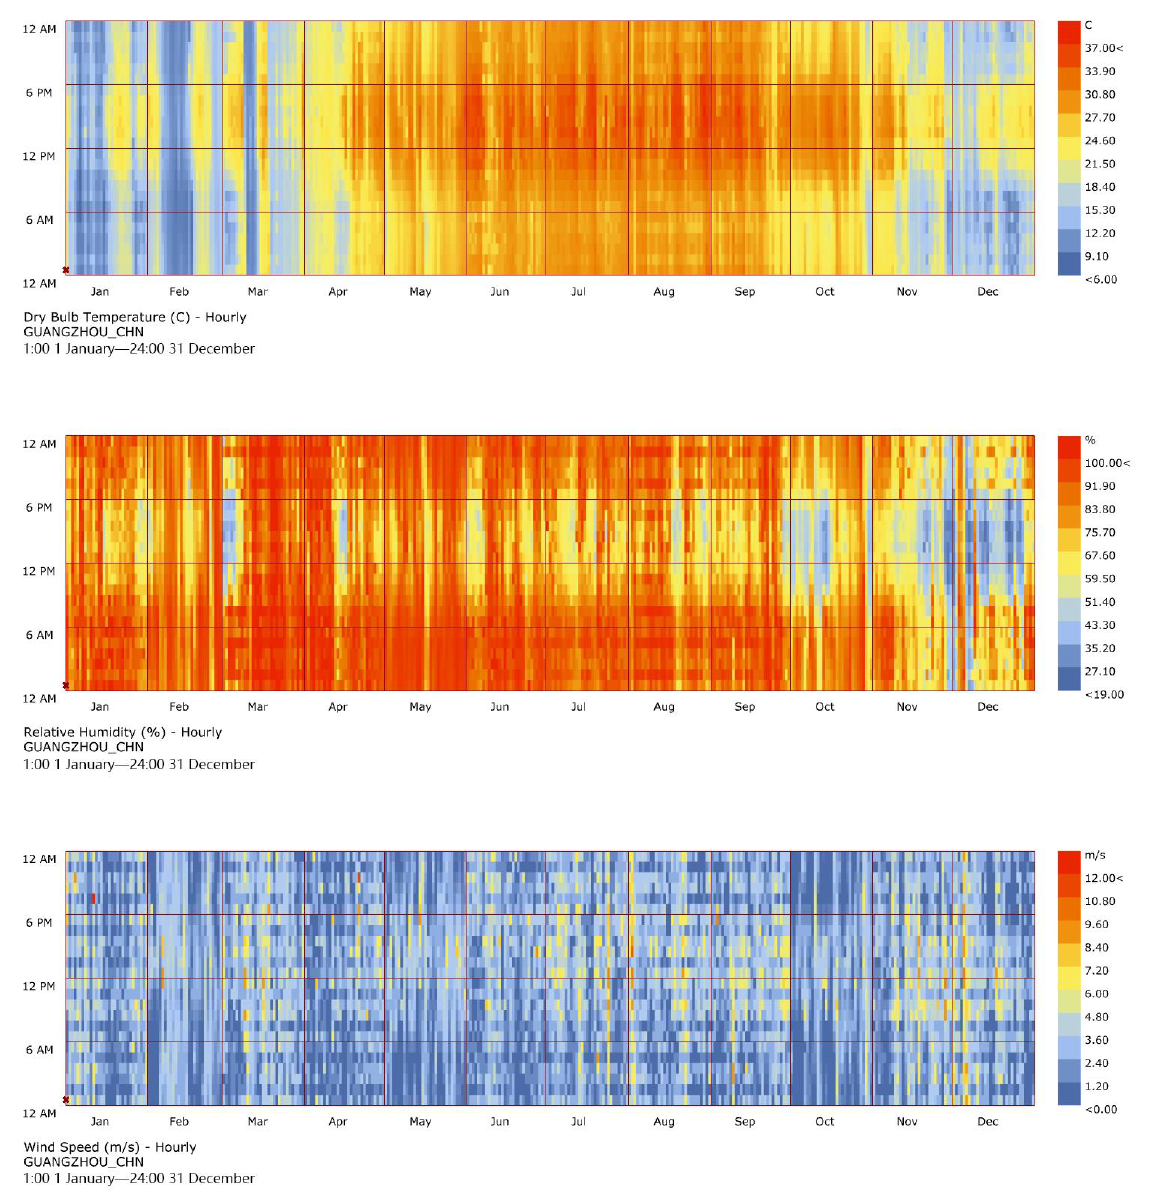
Figure 24. Distribution of Ta, RH, and wind speed for 1 year in Guangzhou in the weather data file visualized with the Ladybug tools (visualized by the students).